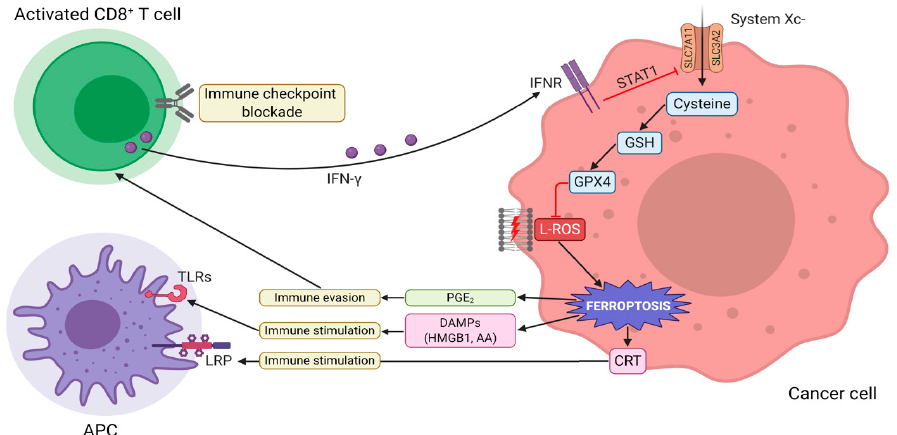
Figure 2. The interaction between tumor immunity modulation and ferroptosis. Immunotherapy- activated CD8+ T cells release IFN- γ , activating INFR. INFR inhibits SLC7A11 transcription through STAT1. This event leads to the downregulation of system Xc-, thus, triggering L-ROS-mediated ferroptosis via GSH-GPX4 axis. Ferroptotic cells release DAMPs (such as HMGB1, CRT, and AA), which, in turn, promote the recruitment and activation of immune cells. Vice versa, the increased release of PGE2 facilitates tumor immune evasion. Abbreviations used: IFN- γ , interferon- γ ; INFR, interferon-receptor; SLC7A11, solute carrier family 7 member 11; SLC3A2, solute carrier family 3 member 2; STAT1, signal transducer and activator of transcription 1; L-ROS, lipid reactive oxygen species; GSH, glutathione; GPX4, glutathione peroxidase 4; DAMPs, damage-associated molecular patterns; HMGB1, high mobility group box 1; CRT, calreticulin; AA, arachidonic acid; PGE2, prostaglandin E2.